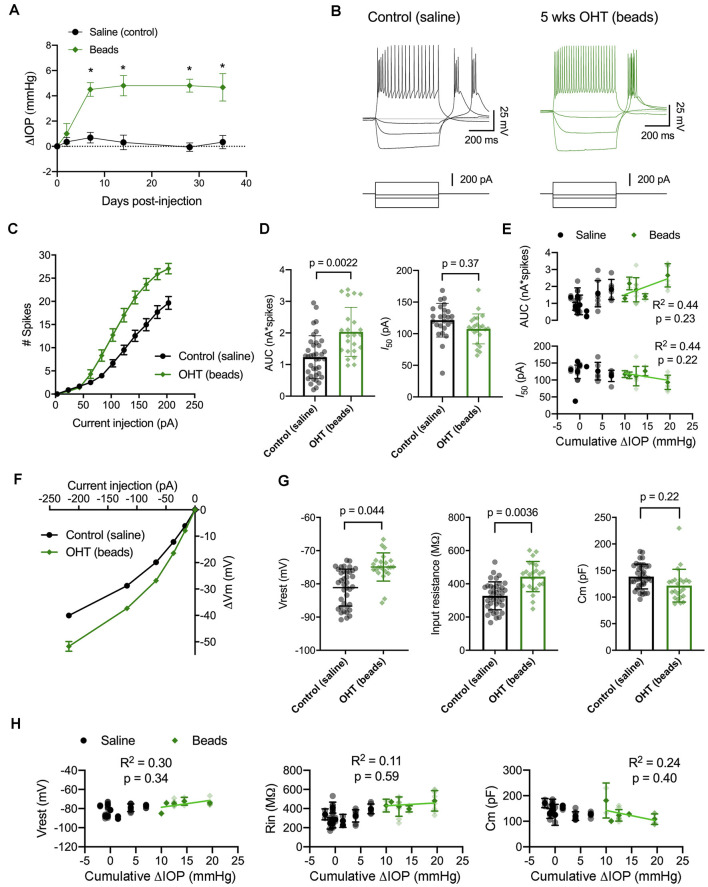
IOP elevation in the microbead model enhances dLGN TC neuron excitability. (A) Following bilateral anterior chamber injection of 10-micron polystyrene microbeads, IOP was elevated by ~5 mmHg (n = 10 eyes from five mice) compared to saline-injected control mice (n = 18 eyes from nine mice; *p < 0.05, unpaired t-test). (B) Whole-cell current-clamp recordings from TC neurons in dLGN coronal slices show spiking and hyperpolarizing voltage responses to depolarizing (+180 pA) and hyperpolarizing (−20, −70, and −220 pA) current injections in TC neurons from saline-and bead-injected mice. (C) Plot of mean ± SEM of current-evoked spiking (*p < 0.05, unpaired t-test). Saline data are from 38 cells from nine mice while microbead data are from 23 cells from five mice. (D) AUC was significantly elevated in cells from bead-injected mice compared to saline-injected controls (nested t-test). I50 was slightly reduced, although not significantly. Bars and error bars show mean ± SD while data points are measurements from individual cells. (E) There was no significant correlation of AUC or I50 with IOP from bead-injected mice as assessed with linear regression. Cumulative ΔIOP represents the between-eyes average of IOP measurements taken at 1, 2, and 4 weeks post-injection. (F) Voltage responses to hyperpolarizing current injections were used to measure passive membrane properties from the same population of cells. (G) TC neurons from bead-injected mice were slightly depolarized relative to saline-injected controls (nested t-test). Rin was significantly elevated and Cm was not significantly different. (H) Passive membrane properties did not significantly correlate with IOP as assessed with linear regression.